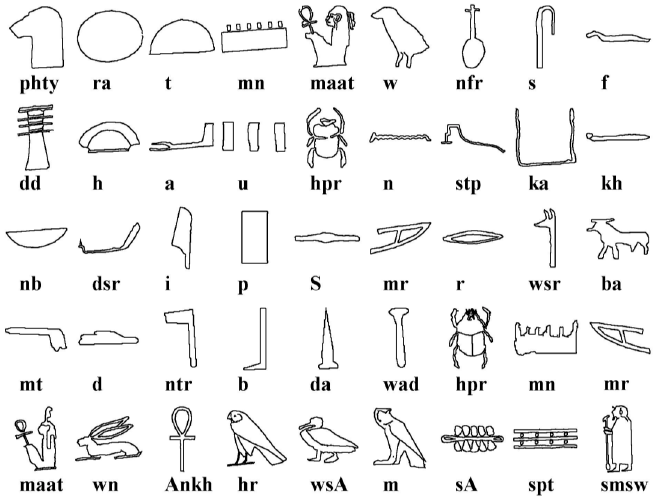
Figure 12. Database of hieroglyphs obtained from the Abydos King List.